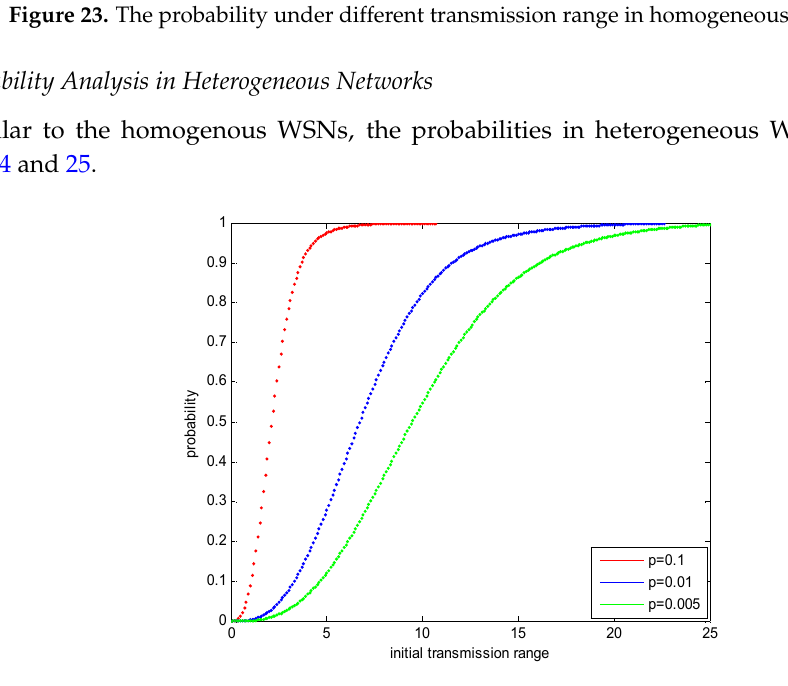
Figure 24. The probability under different node density and original transmission range in heterogeneous networks.